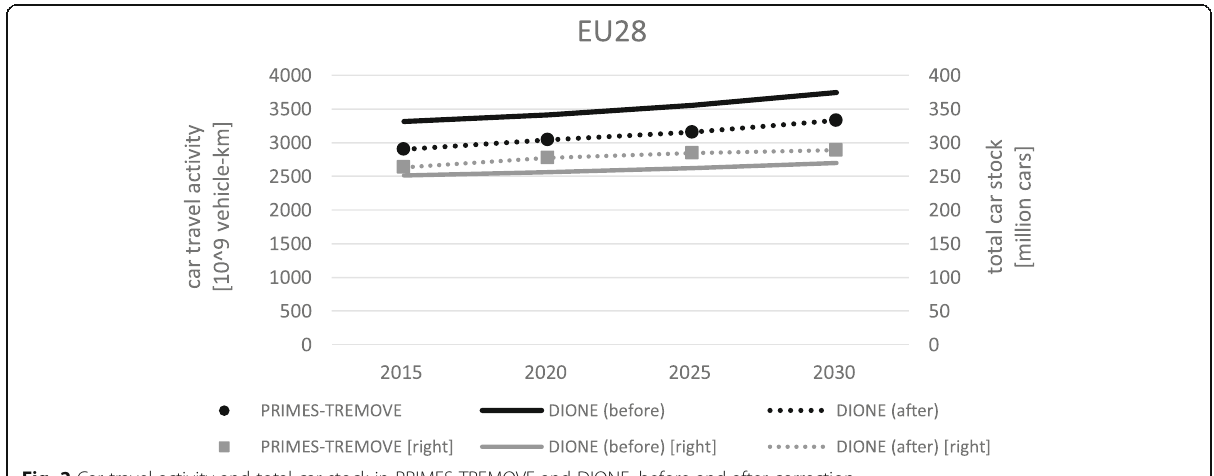
Fig. 2 Car travel activity and total car stock in PRIMES-TREMOVE and DIONE, before and after